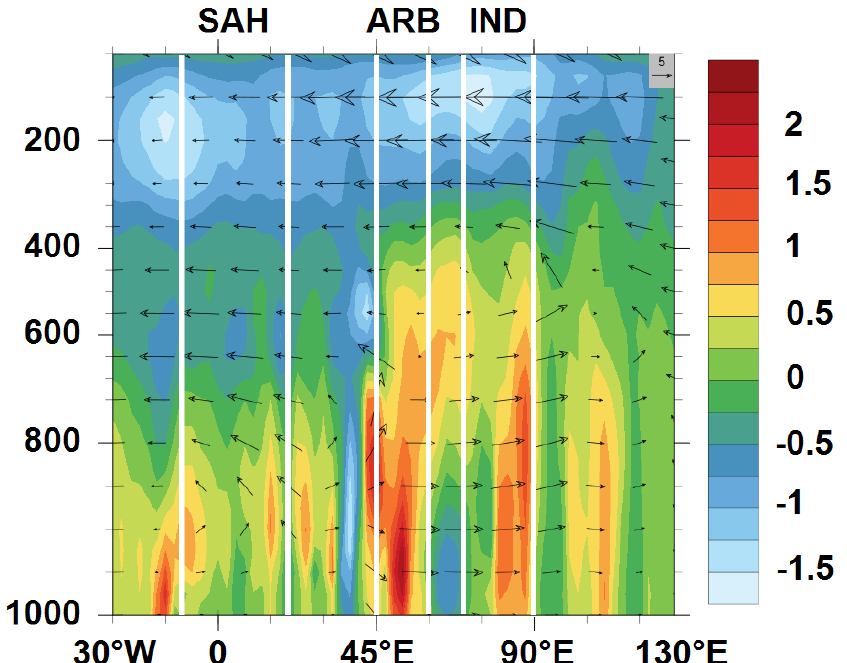
Figure 2. Zonal cross section of the zonal and vertical component of the wind (vectors) and the relative vorticity (×10 5 , s −1 colors) averaged between 10−23° N from June to September over the period 1998–2008, and from 30° W to 130° E. The longitudes of SAH, ARB, and IND regions are marked by white vertical lines.